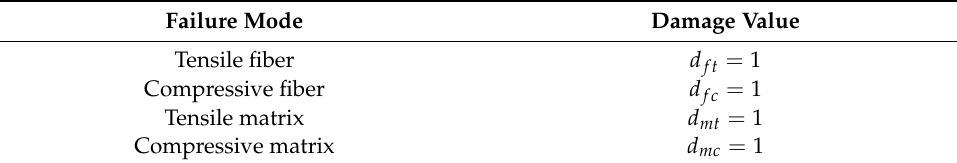
Table 2. Damage values for each failure